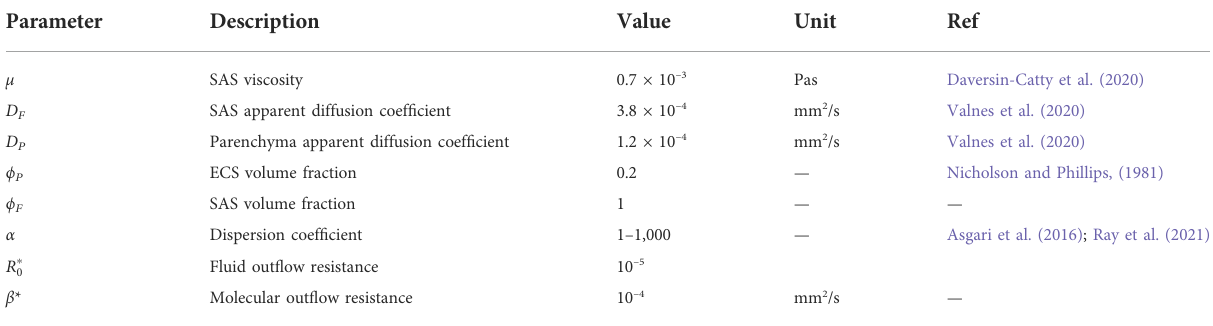
TABLE 1 Overview of parameter values used in the model. Parameters with an asterisk are considered uncertain and were set to vary between different computational models (see Table 2). Parameter